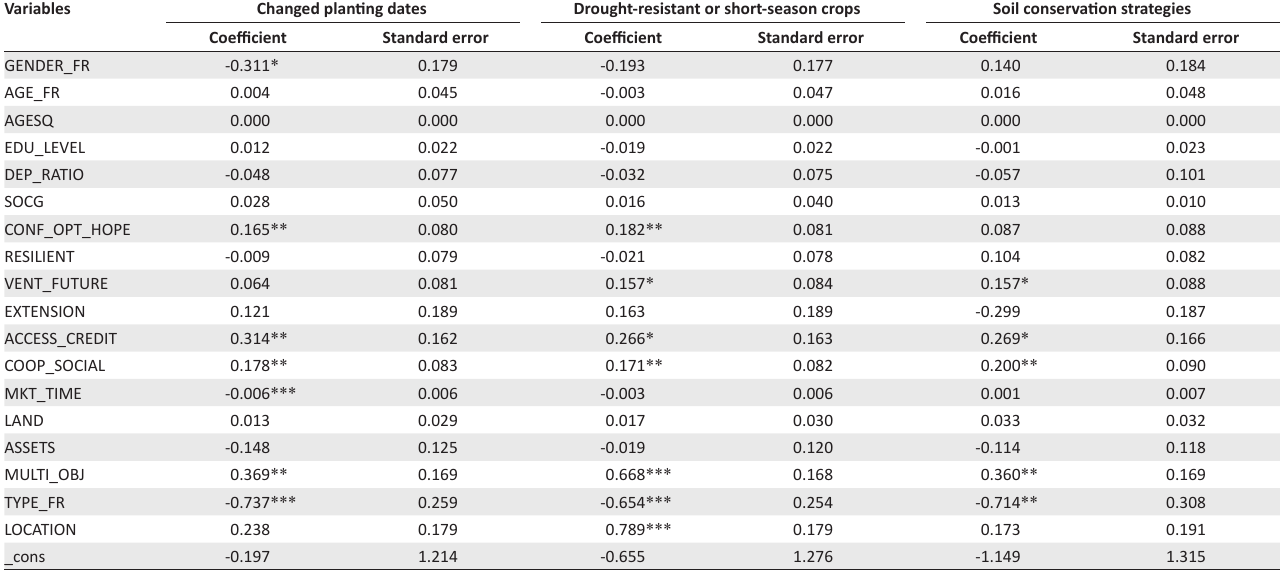
TABLE 3: Multivariate probit regression model estimation results.